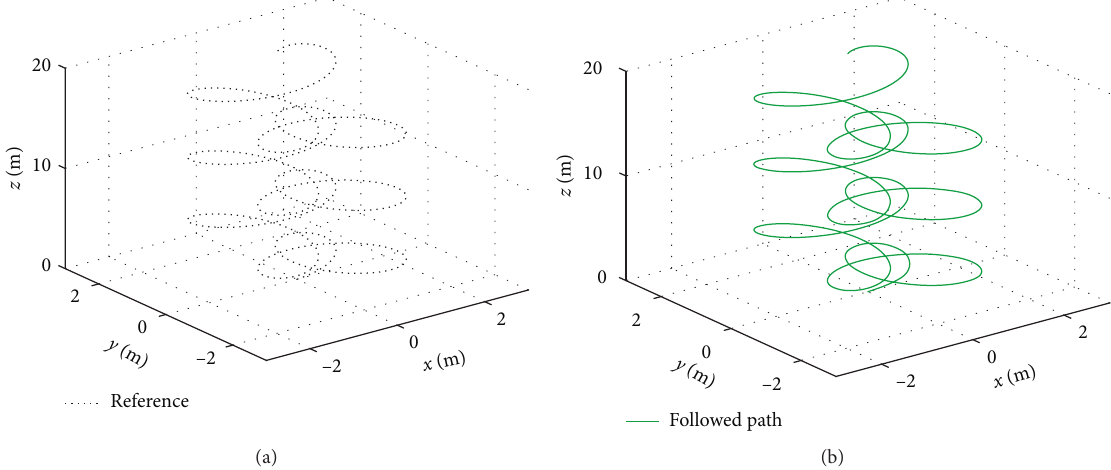
Figure 10: Following of the reference path specified for the controlled quadrotor motion, case